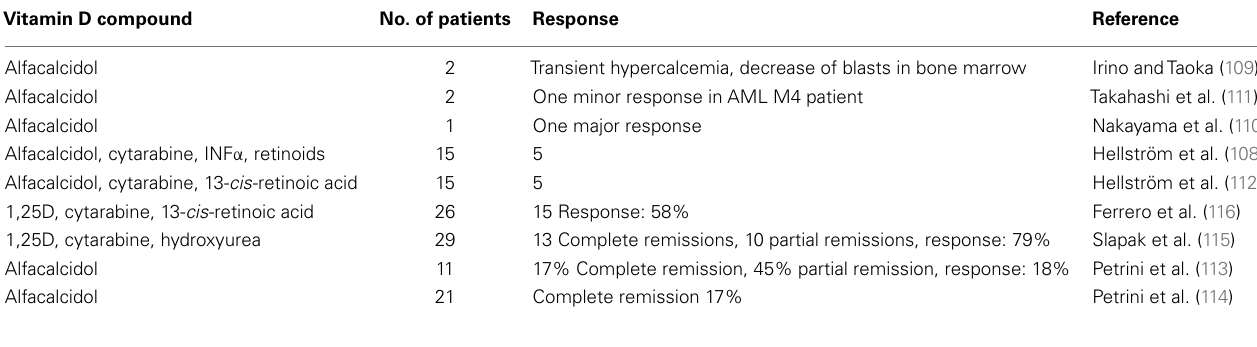
Table 2 | Clinical trials using vitamin D compounds inAML patients (117)